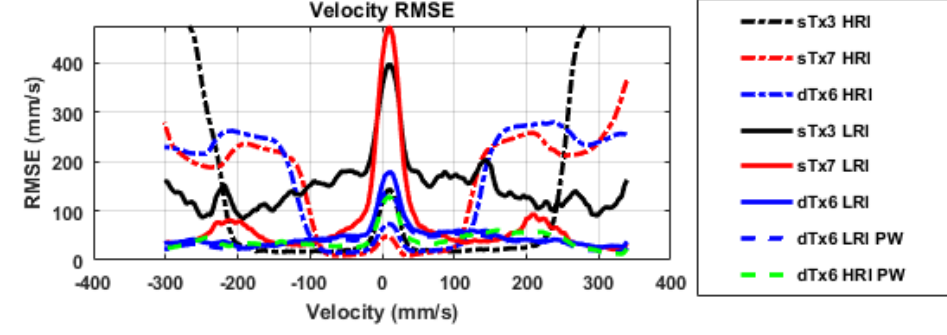
Figure A1. In the HRI estimators, the aliasing manifests as plateauing in the root-mean-square error (RMSE), resulting from the lower frame rate. All other estimators appear to predominately track the standard deviation shown in Figure A2.